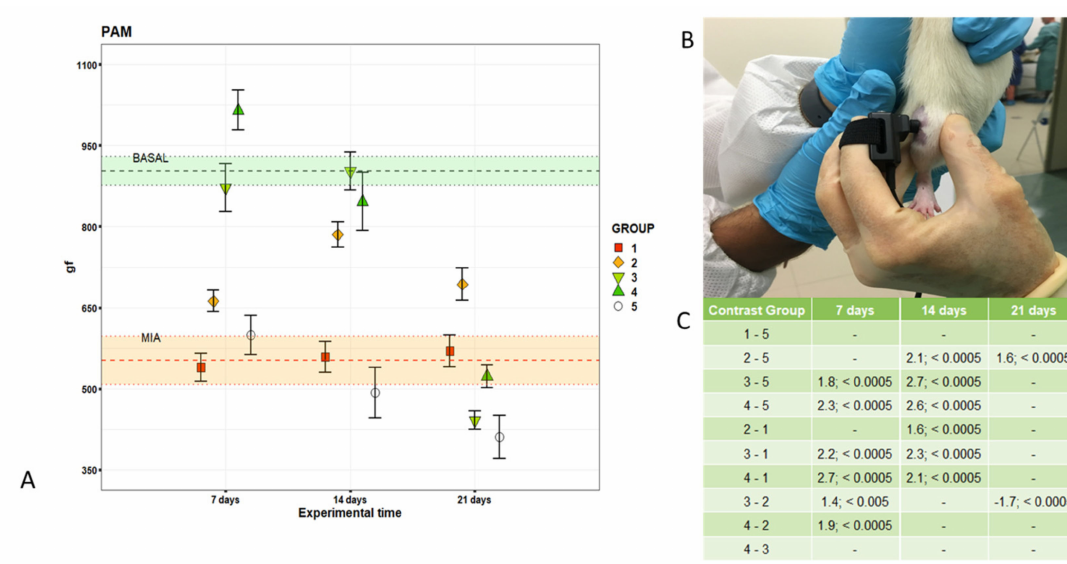
Figure 1. Local pain sensitivity (pressure application measurement (PAM)) results. ( A ) Dot plot of PAM for each treatment measured at treated knee joints at each experimental time; dots indicate mean and error bars indicate standard error (SE). Pain threshold values (mean and SE) measured at baseline (BASAL) and seven days after MIA (MIA) are reported as green and orange zones. The selected Linear mixed models (LMM) model showed a significant interaction of treatment and experimental time factors (F = 10.46, p < 0.0005). ( B ) Image of measurement of the limb withdrawal threshold. ( C ) Pairwise comparisons ( d -value; p -value). Group 1: TA; group 2: HY-CTL; group 3: RV2; group 4: RV4.5; group 5: NaCl. gf: